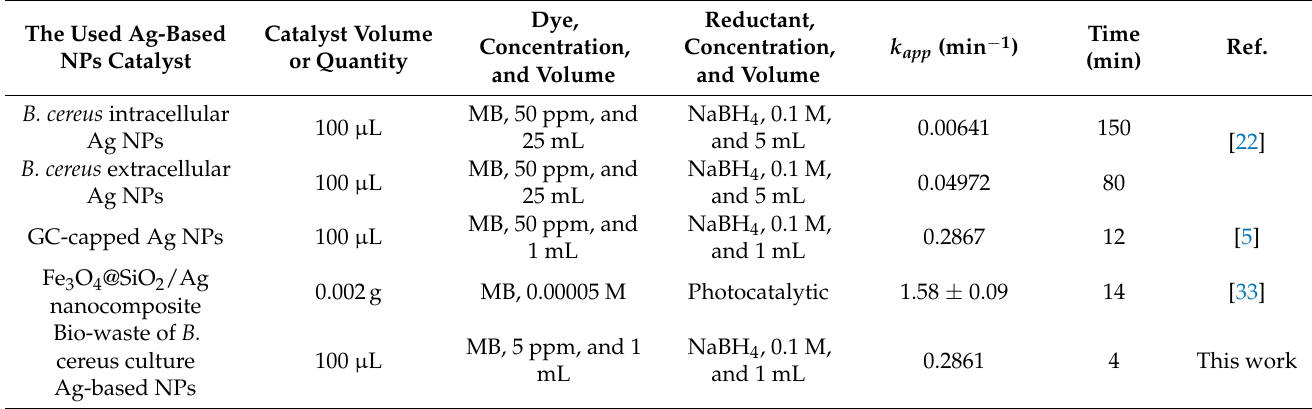
Table 2. Comparison between different fabricated Ag-based nano-catalysts and our bio-waste Ag- based NPs concerning reaction and performance